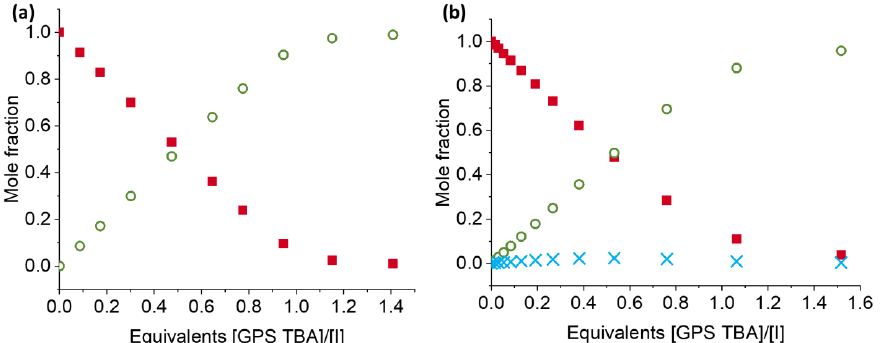
Figure 4. ( a ) Species distribution of [ I ] (red squares) and [ I -GPS-TBA] (green circles) during the titration in CHCl 3 , with fitting to 1:1 stoichiometry using BindFit. ( b ) Species distribution of [ I ] (red squares), [ I -GPS-TBA] (green circles) and [ I 2 -GPS-TBA] (blue crosses) during the titration in MeCN, with fitting to I :GPS-TBA 2:1 stoichiometry using